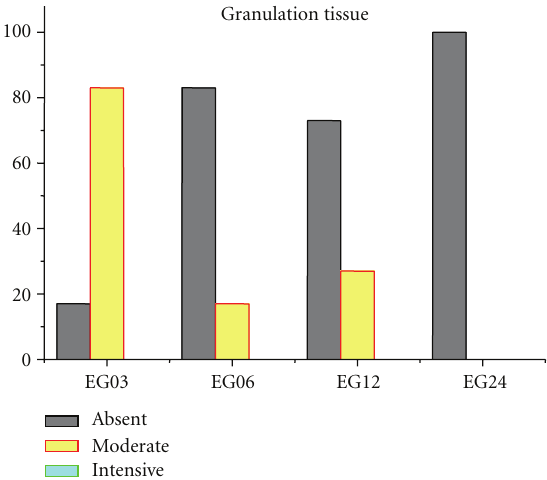
Figure 9: Mean granulation tissue in EGs samples. A 68% absence and 32% moderate presence was observed, however intensive presence was not observed in any of the EGs.